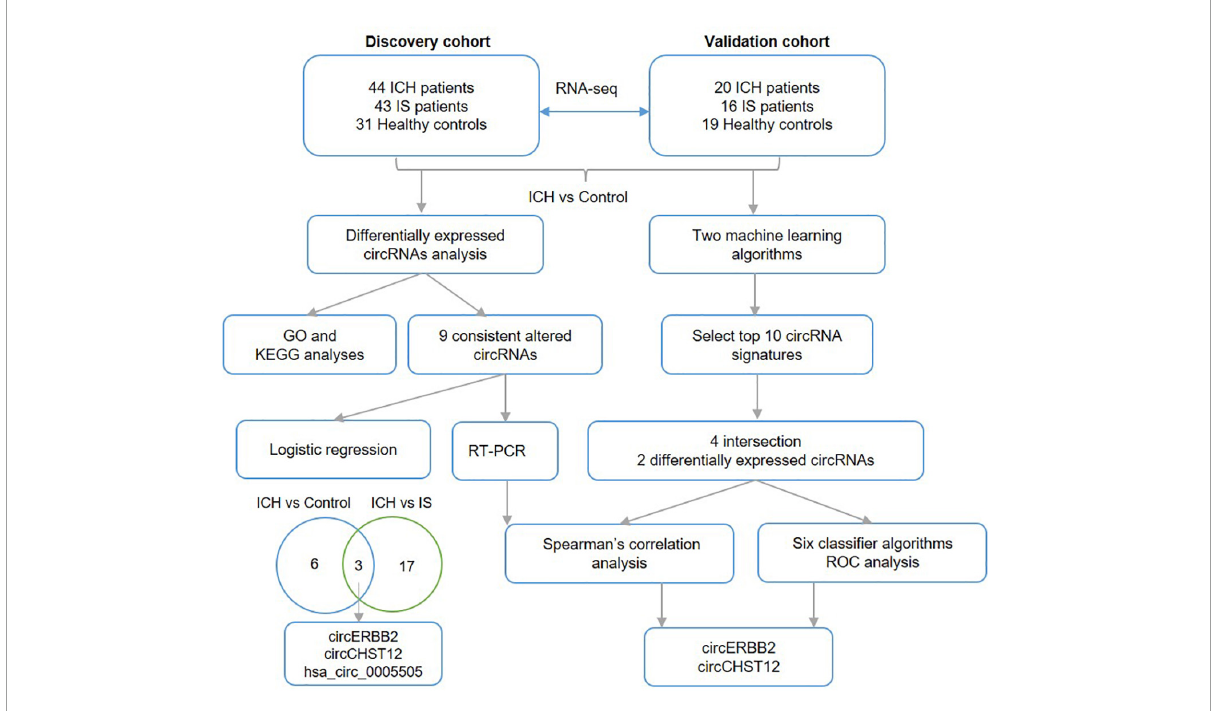
FIGURE8 Work flow. The diagram of the data analysis process in this